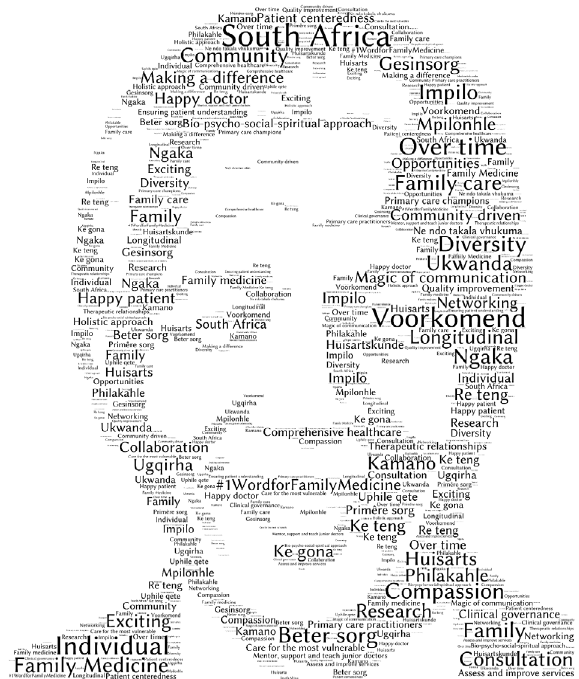
Figure 2: The second selected #1WordforFamilyMedicine South Africa image, based on former president Nelson